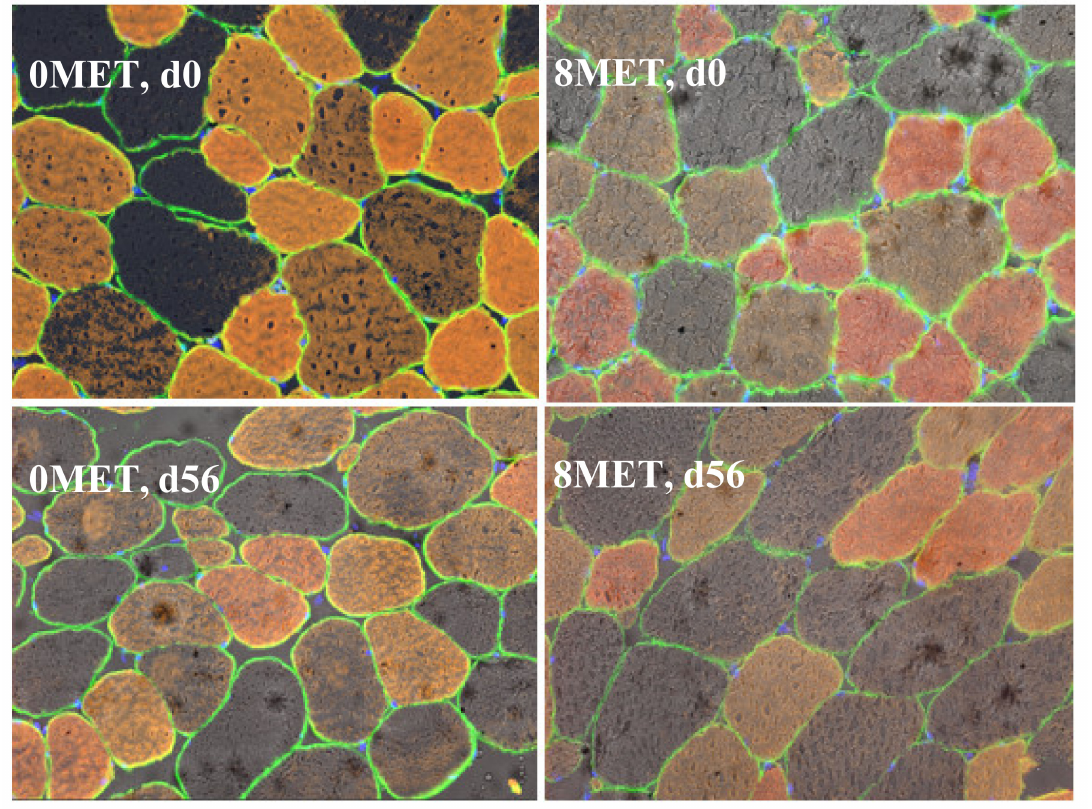
Figure 2. Immunohistochemical detection of muscle fiber type distribution and cross-sectional area in longissimus tissue. Red = type I fibers, yellow = type IIA fibers, gray/no stain = type IIX fibers, green = sarcolemma, blue = nuclei. 0MET = 0 g encapsulated methionine and 4 g encapsulated lysine per hd/d, 8MET = 8 g encapsulated methionine and 4 g encapsulated lysine per hd/d. Table 10. Effect of encapsulated amino acids on muscle nuclei and satellite cell density in longissimus tissue. Type per mm 2